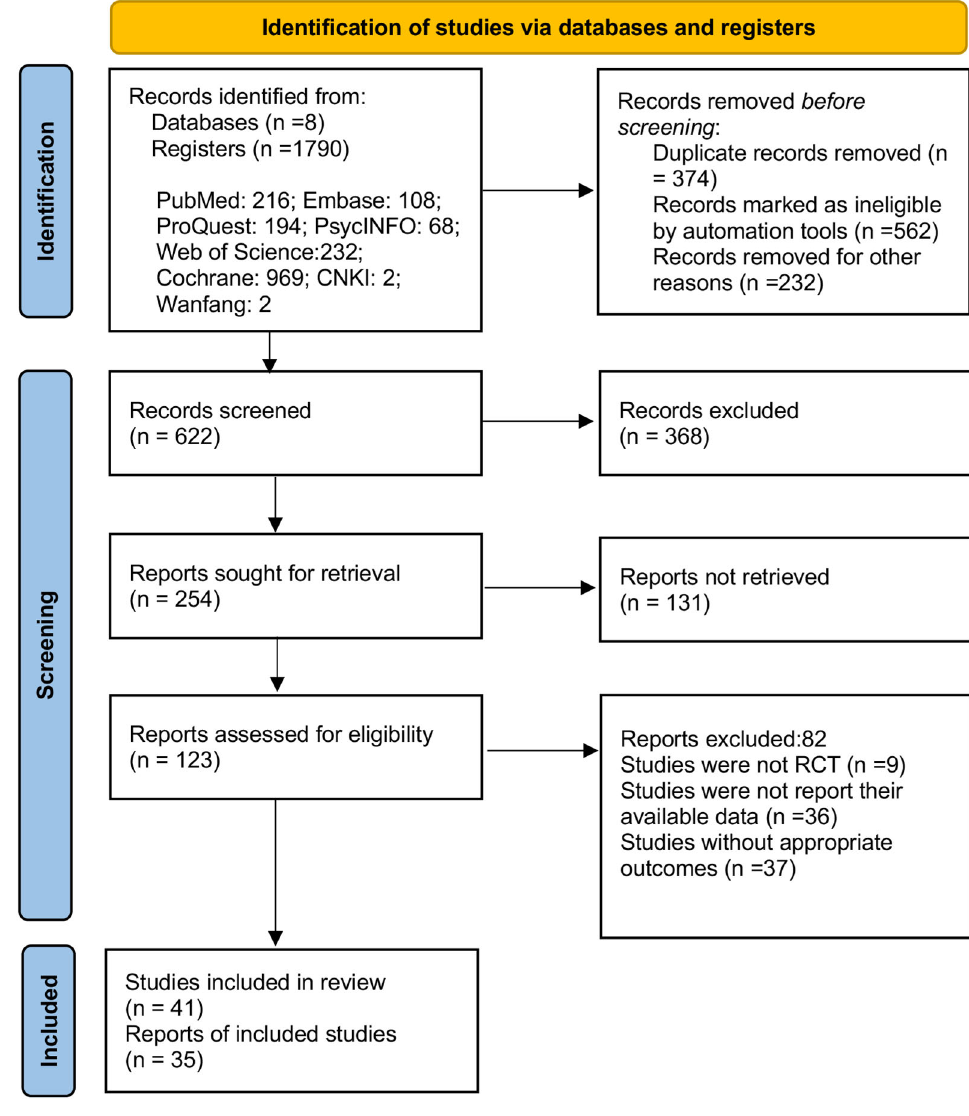
Figure 1. Flow chart of study design by PRISMA 2020.